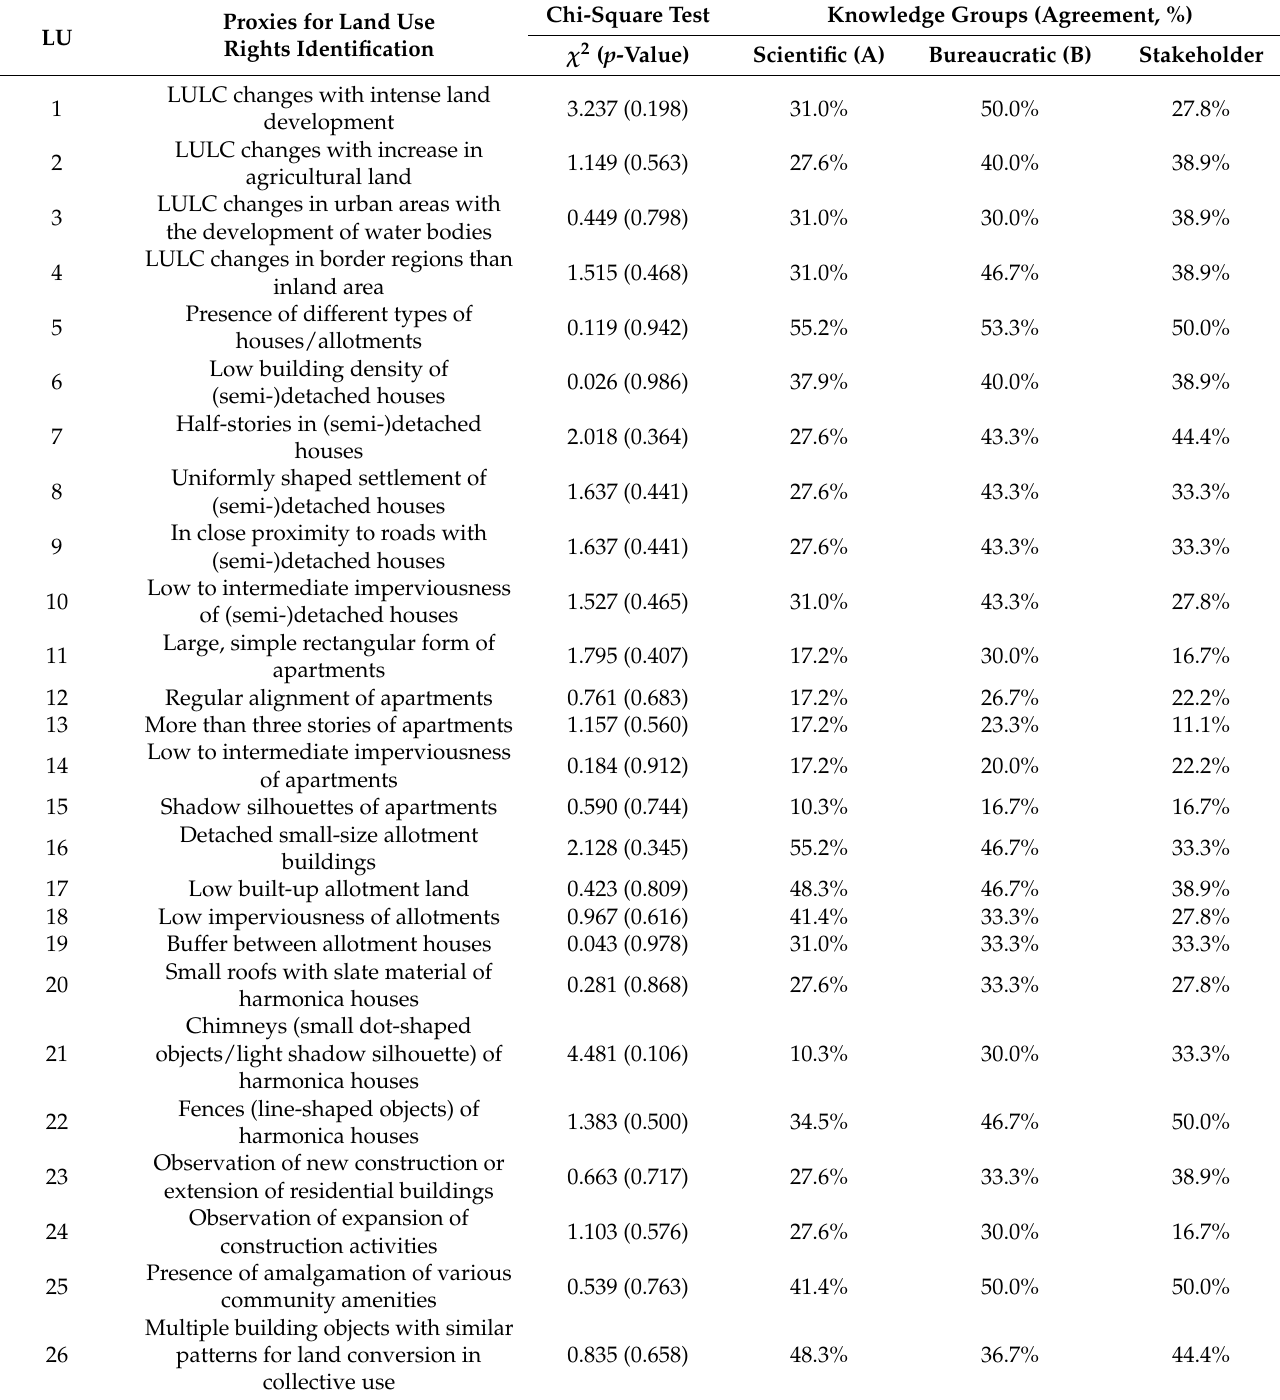
Table 3. Validating the suitability of proxies for land use rights identification and differences between knowledge groups.